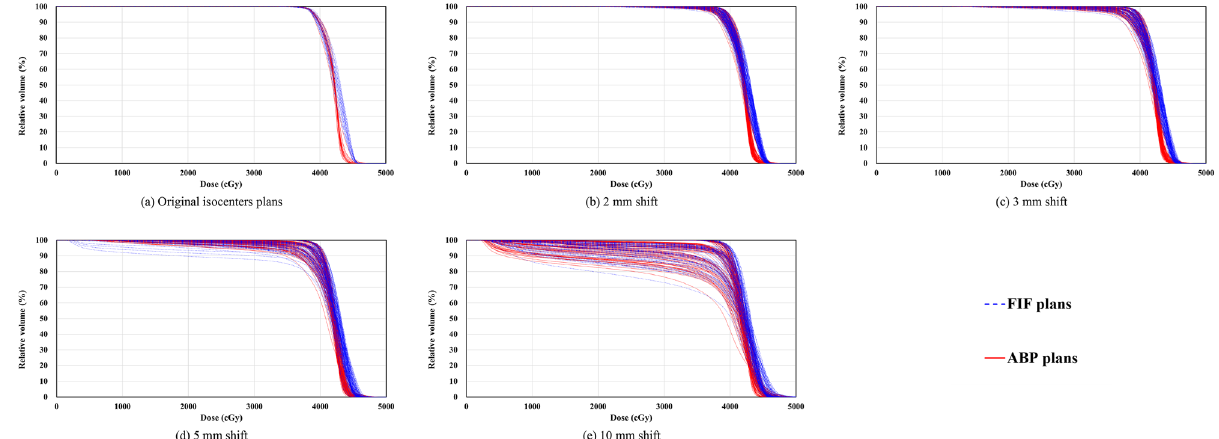
Figure 1. Comparison of dose-volume histograms of 90% dose-volume among FIF plans and ABP plans. FIF, field-in-field technique; ABP, automated breast planning. The prescribed 90% dose volume was created from isodose line in each FIF and ABP original isocenters